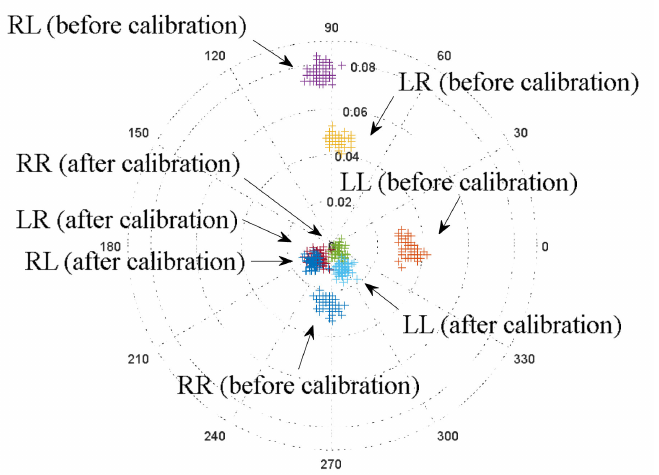
Figure 8. Target marks of the received wave relative to the normalized transmitted signal in polar coordinates before and after calibration (circular polarization, car, profile angle 0 ◦ , number of marks for each observation—64): LL—left-hand circular transmission and left-hand circular reception; RR—right-hand circular transmission and right-hand circular reception; RL—right-hand circular transmission and left-hand circular reception; LR is left-circular transmission and right-hand circular